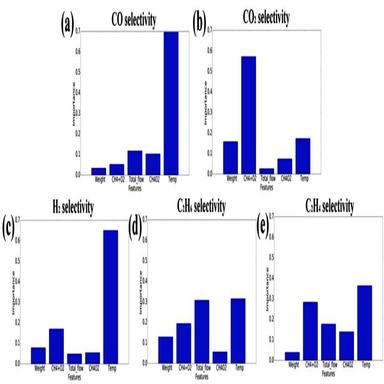
Importance of descriptors within the random forest regressor model against (a) CO selectivity, (b) CO2 selectivity, (c) H2 selectivity, (d) C2H6 selectivity, and (e) C2H4 selectivity. Reproduced with permission from American Chemical Society.